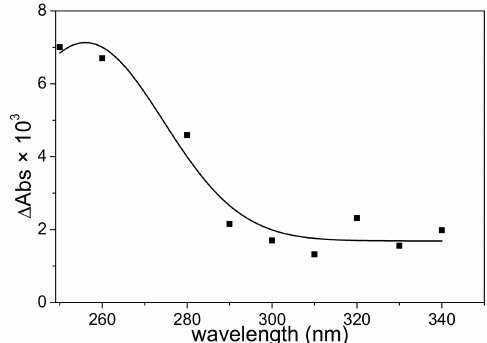
Figure 4. LFP of 50 mM sulfite at pH 9.5 in air-saturated solution. Transient absorption spectra at 1.2 µ s delay (points) after excitation corresponding to the SO 3 •− radical.